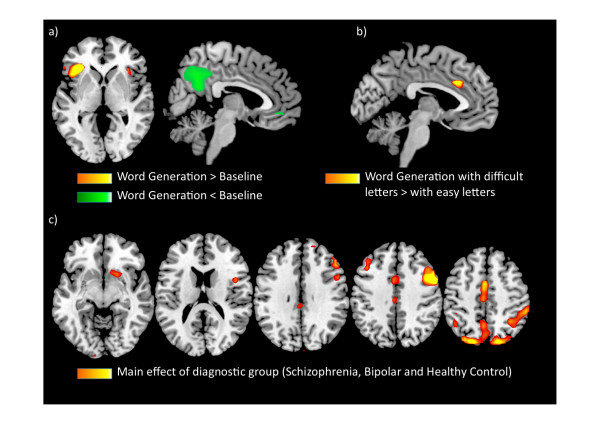
Patterns of activation during word generation. Significant activations during verbal fluency according to SPM random-effects analysis for the whole subject sample (a and b, slices at x = 0, z = +4 and x = -4) and diagnostic effects (c, slices at z = -8,16,40,48), adjusted by sex and antipsychotic dosage. (MNI space, images are in MNI space and +x on the right). Results are multiple-comparisons corrected with cluster-level significance level of p < 0.05.